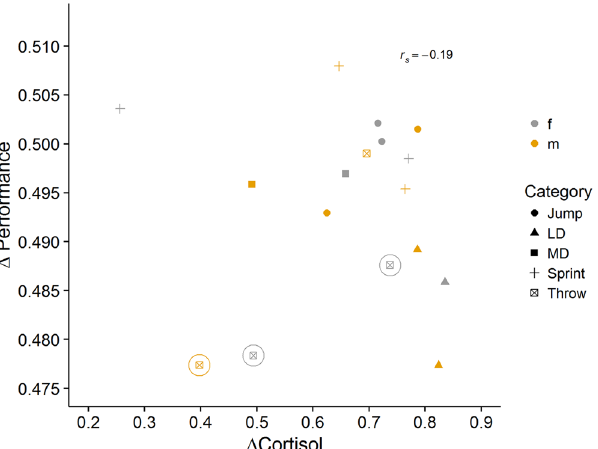
Figure 3. Correlation of cortisol change prior to competition, Δ C (X-axis) and performance; Δ P (Y-axis). Each symbol represents an individual athlete; color indicates sex of the athlete, shape indicates the category the athlete started in, LD = long distance running, MD = middle distance running, Jump = jumps, Sprint = sprints, Throw = throws. Athletes marked with a circle were less involved in competitive athletics than the other athletes.